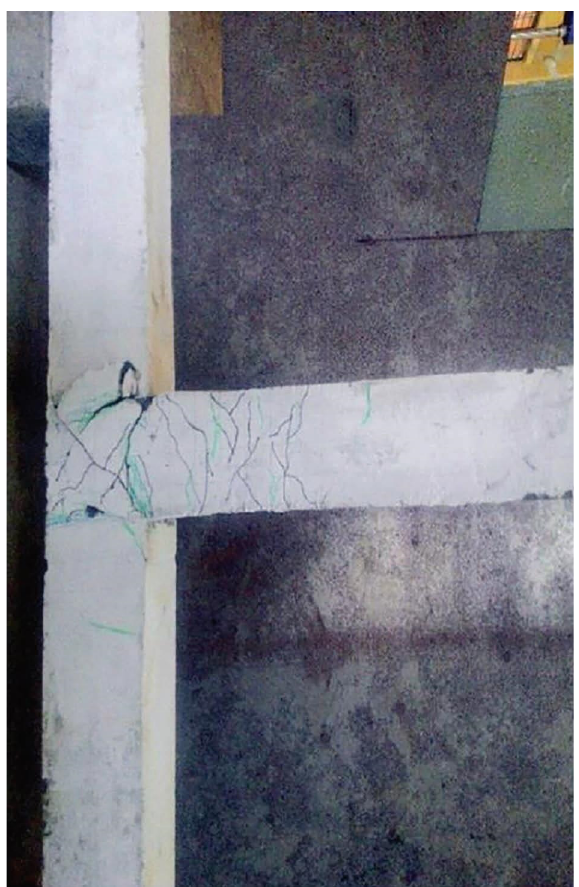
Figure 7: Fracture patterns of Alccofne